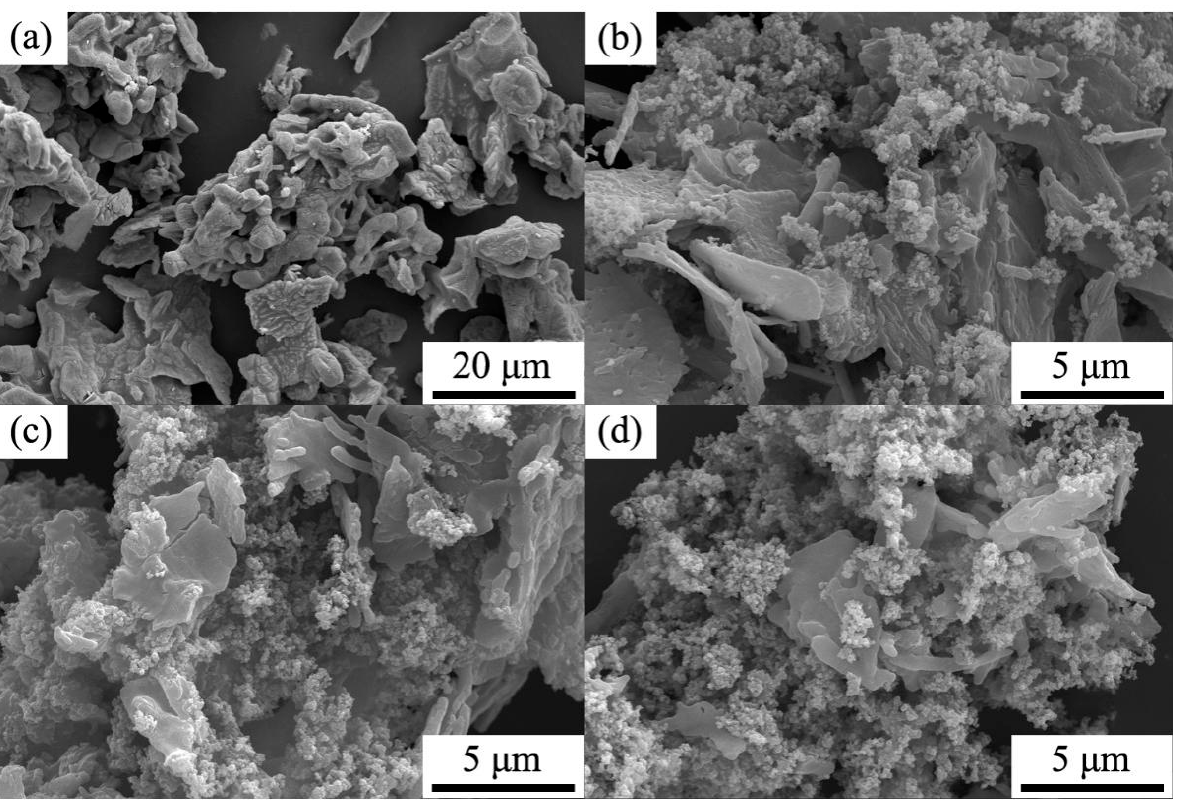
Figure 1. The SEM images of all composites. ( a ) The SEM image of CNC; ( b ) The SEM image of CNCG-1; ( c ) The SEM image of CNCG-2; ( d ) The SEM image of CNCG-3.